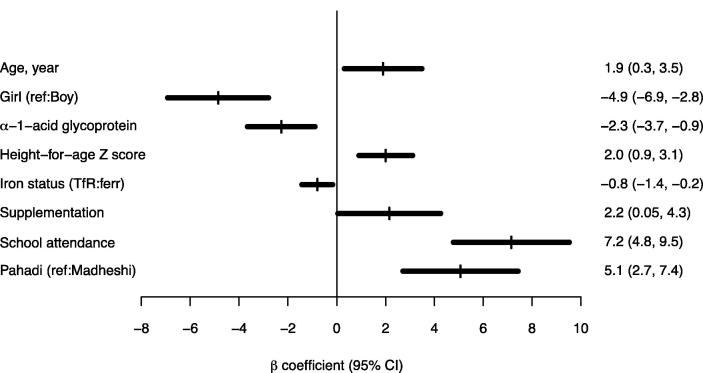
Associations between intelligence test score and alpha-1-acid glycoprotein (AGP) and other risk factors in a multivariate model in school-aged children in rural Nepal (n = 247). Abbreviation: Transferrin receptor to ferritin ratio, TfR:ferr. X-axis denotes expected difference (or change) in UNIT score adjusting for other covariates in the multivariate model. For AGP and iron status, estimated change in UNIT score was associated with a 50% increase in plasma AGP (g/L) and TfR:ferr (μg/μg) concentration, respectively. A high TfR:ferr value represents poor iron status. Supplementation represents children whose mothers received antenatal micronutrient supplements during their pregnancy that included iron and folic acid (vs. supplements that did not) during the original randomized clinical trial (Christian et al., 2010). Pahadi and Madheshi represent two major ethnic groups. Childhood iron-folic acid supplementation variable was included as a fixed covariate in the multivariate model [β (95% CI) = −1.4 (−3.5, 0.7), P = 0.1872] (not illustrated). Maternal education and household wealth index variables were not significantly associated with the outcome (P > 0.05) and dropped from the model.